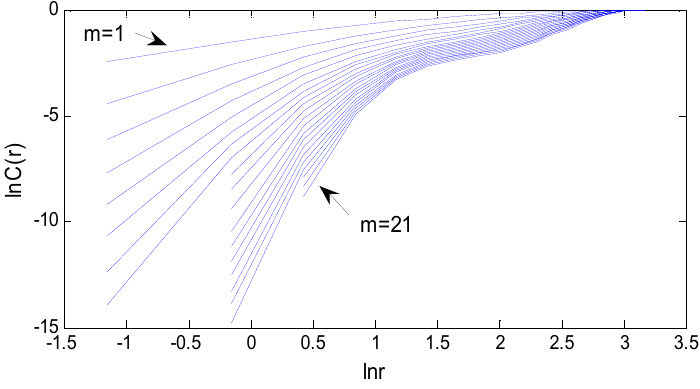
Figure 5. The curves of lnr — lnC ( r ) for BOD dataset.